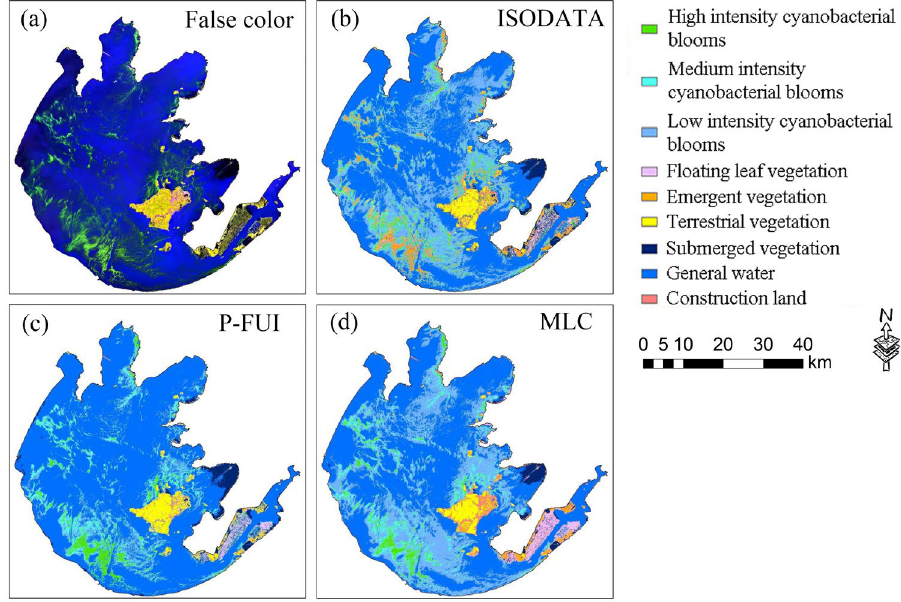
Figure 11. Comparison of CBs identification based on ( a ) false color composition, ( b ) ISODATA clustering, ( c ) P-FUI decision tree, and ( d ) maximum likelihood classification methods.